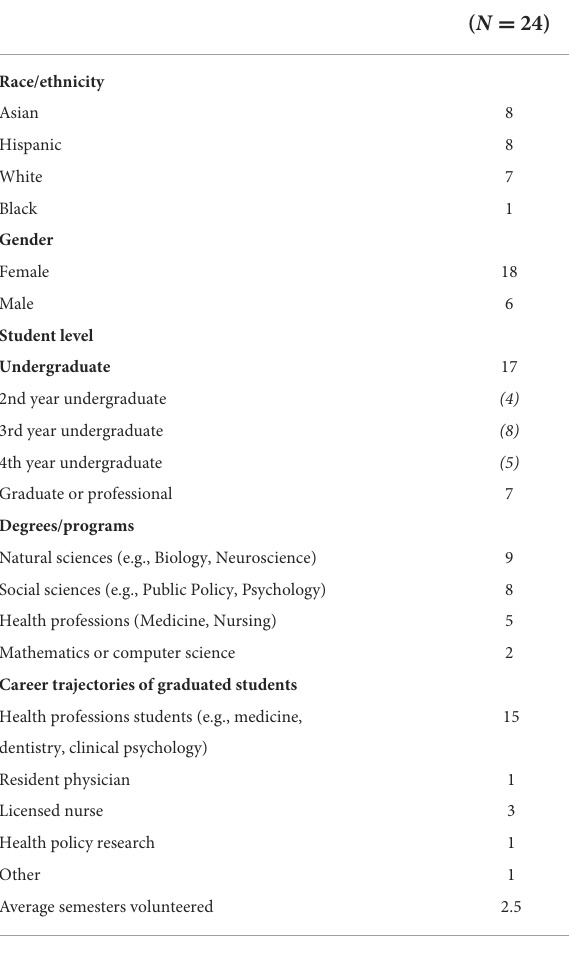
TABLE 1 Student volunteer characteristics.